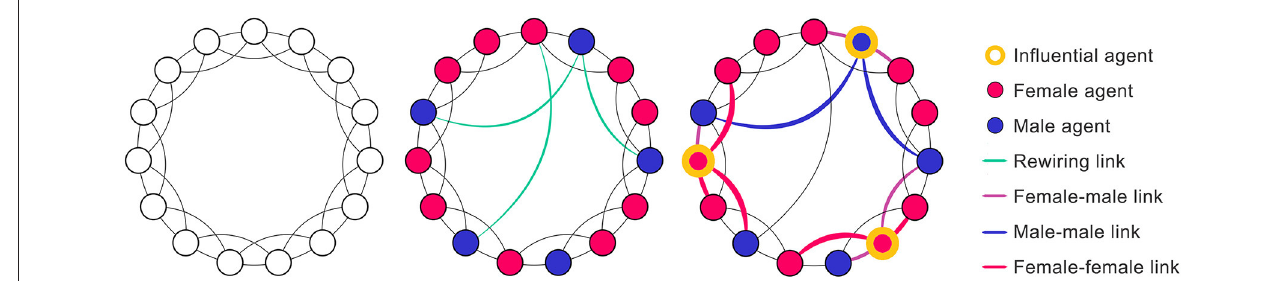
FIGURE 1 | The building process of the Watts–Strogatz small-world model with gender contexts.